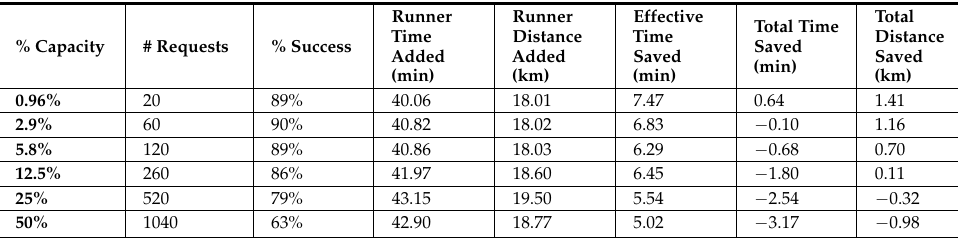
Table 8. Results from subsampled Manhattan feasibility